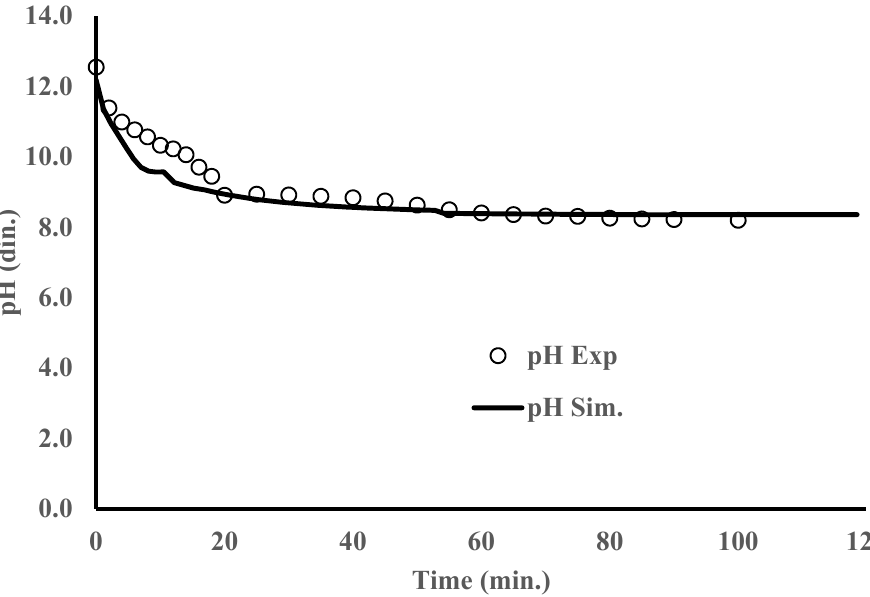
Figure 6. Comparison between experimental data and simulation results.